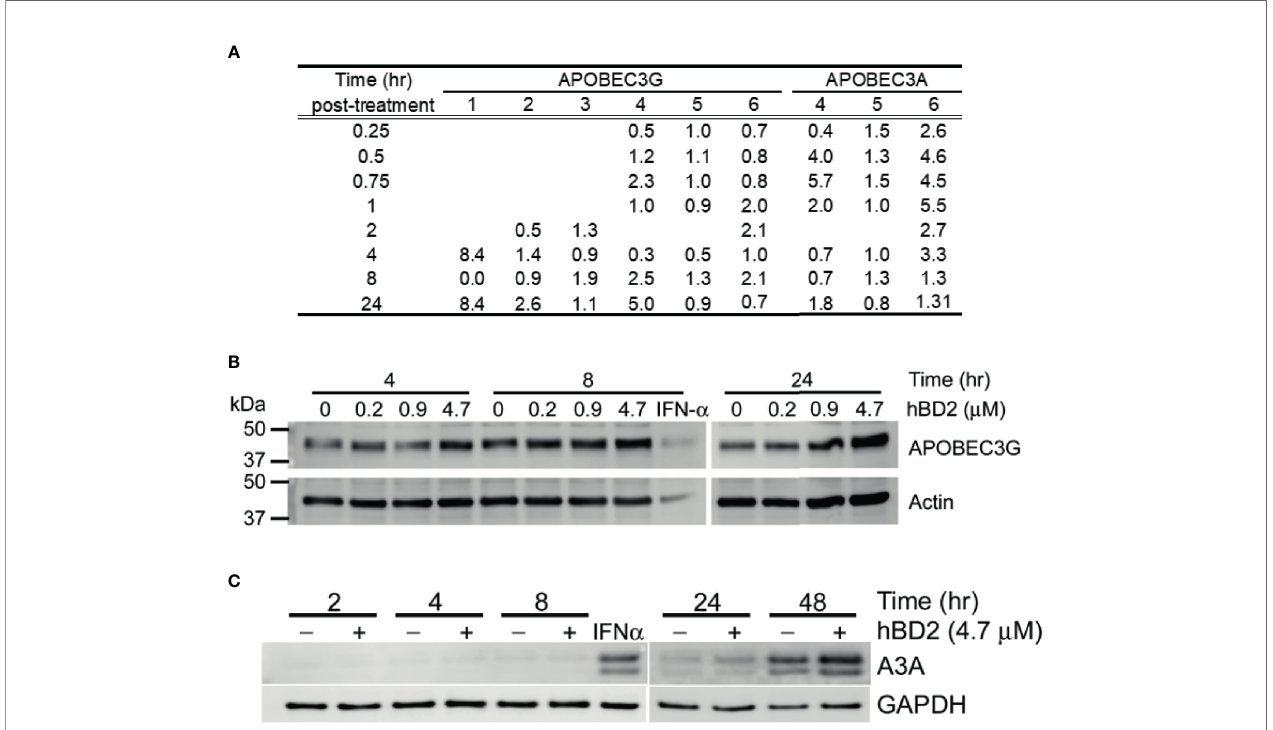
FIGURE 7 | hBD2 upregulates APOBEC3G and/or APOBEC3A in macrophages. (A) APOBEC3G and APOBEC3A expression in response to hBD2. MDM were treated with hBD2 for indicated times and mRNA levels were assessed by quantitative real-time RT-PCR. The data was normalized to 18S ribosomal RNA. Triplicate measurements were used to calculate fold change as described in Materials and Methods . Data are presented as fold change in treated samples compared to untreated samples at matched time points. Data are for independent experiments from different donors. Analyses of APOBEC3G (B) and APOBEC3A (C) protein levels in response to hBD2. MDM were treated with hBD2 for various times and cell lysates were used to detect APOBEC3G and APOBEC3A proteins by western blotting. ß-actin and GAPDH serve as load controls. Representative experiment,